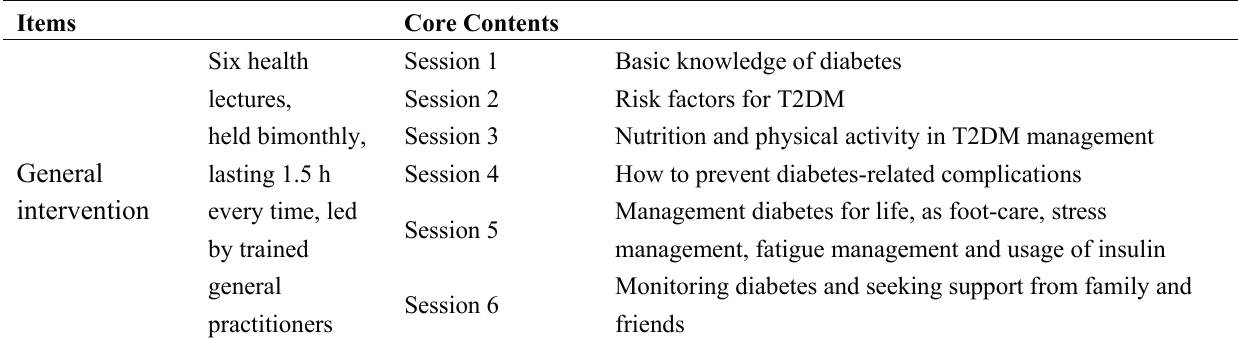
Table 1. The community-based comprehensive